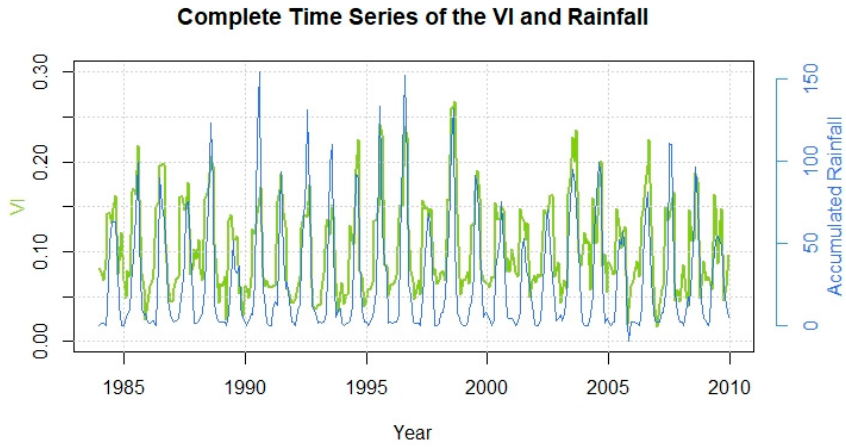
Figure 10. Time series of NDVI and rainfall for the pixel in Figures 8 and 9.